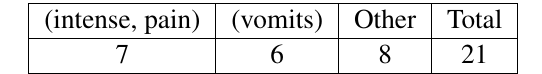
Table 5: Strong matching example for a partition associated to a